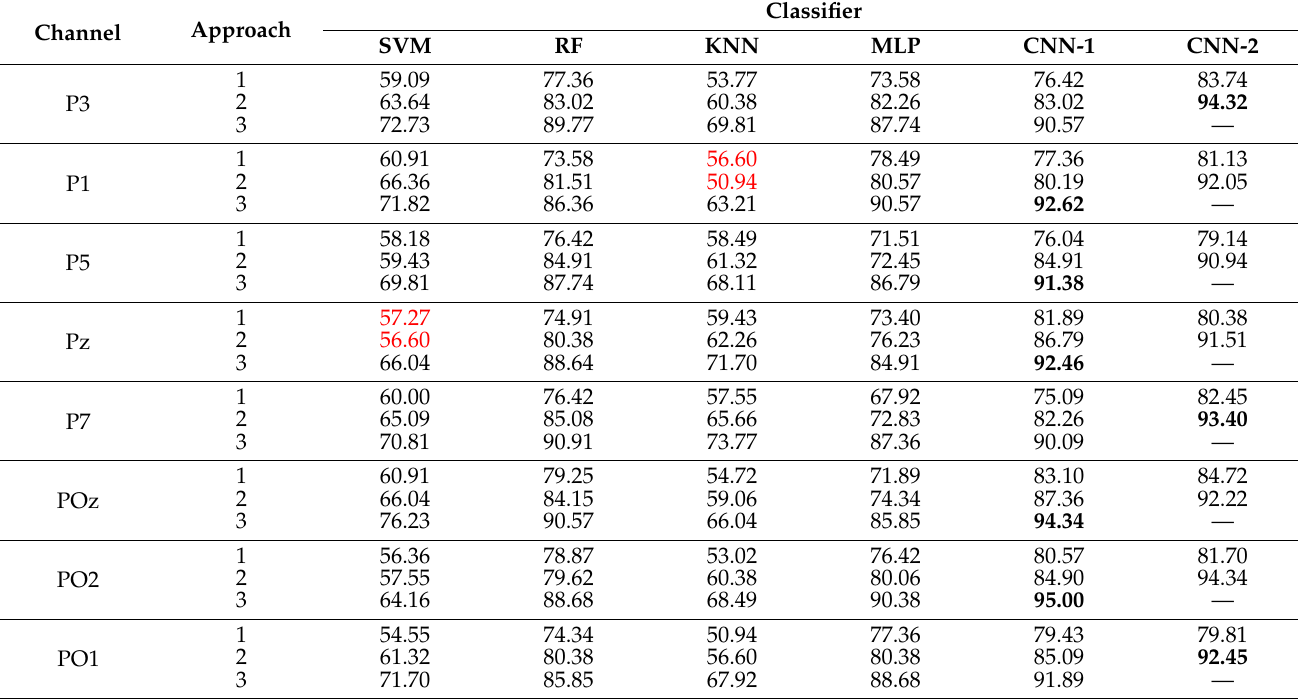
Table A1. Classification accuracies of the ERPs of Subject b 1 . Inconsistent results are highlighted in red. The best result for each channel is highlighted in bold font.